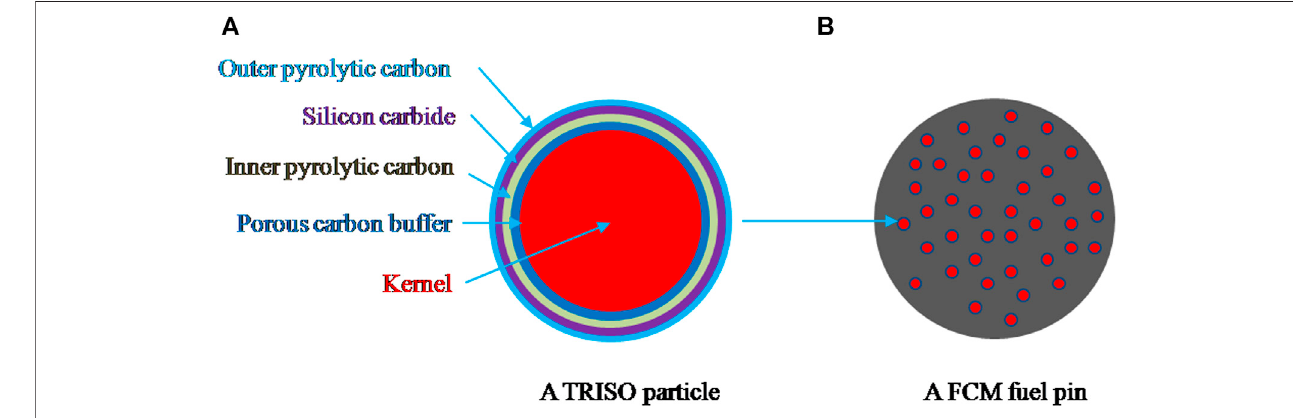
FIGURE 1 | Design of FCM fuel.